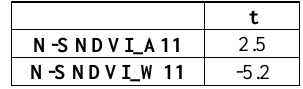
Figure 5. Pixel to pixel correlation between the all AOI pixels of NDVI_A11 and the all AOI pixels of resampled NDVI_W11. Table 6. Student t-test results relative to the N and S average NDVI differences for each image. However, the single AOI behavior is different. While for the pixel to pixel linear correlations of N, S and C1 areas the angular coefficient ranges from 0.71 to 0.99, the C2 coefficient (0.2) proves the almost total invariance of the NDVI_W11 compared to NDVI_A11. This anomalous behavior is evident also in Fig.6. The graph shows the relationship between the average NDVI_W11 AOI values and the average NDVI_A11 AOI values. The error bars are a graphical representation of the standard deviations of each average value while the red line